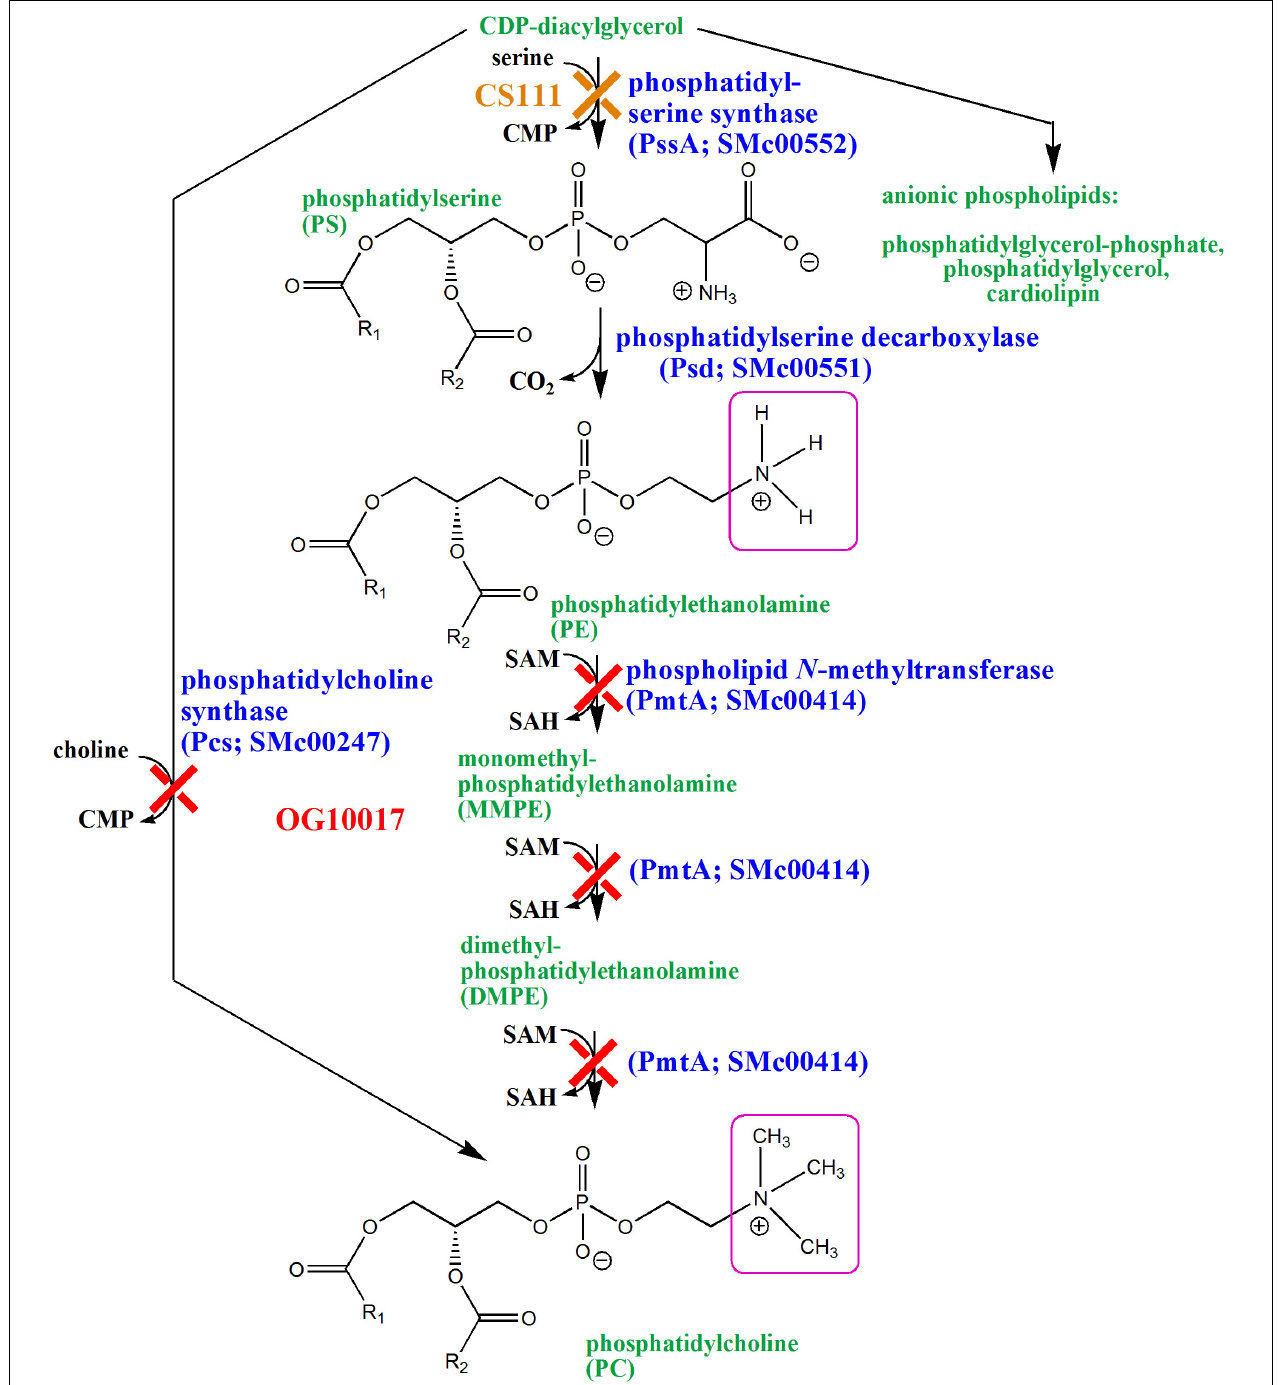
FIGURE 1 | Biosynthesis of phospholipids in Sinorhizobium meliloti wild type and in mutants deficient in PE (CS111) or PC (OG10017) formation. Cytidine monophosphate (CMP), cytidine diphosphate (CDP), inorganic phosphate (P i ), S -adenosylmethionine (SAM), S -adenosylhomocysteine (SAH). Structural differences between PE and PC are highlighted by pink